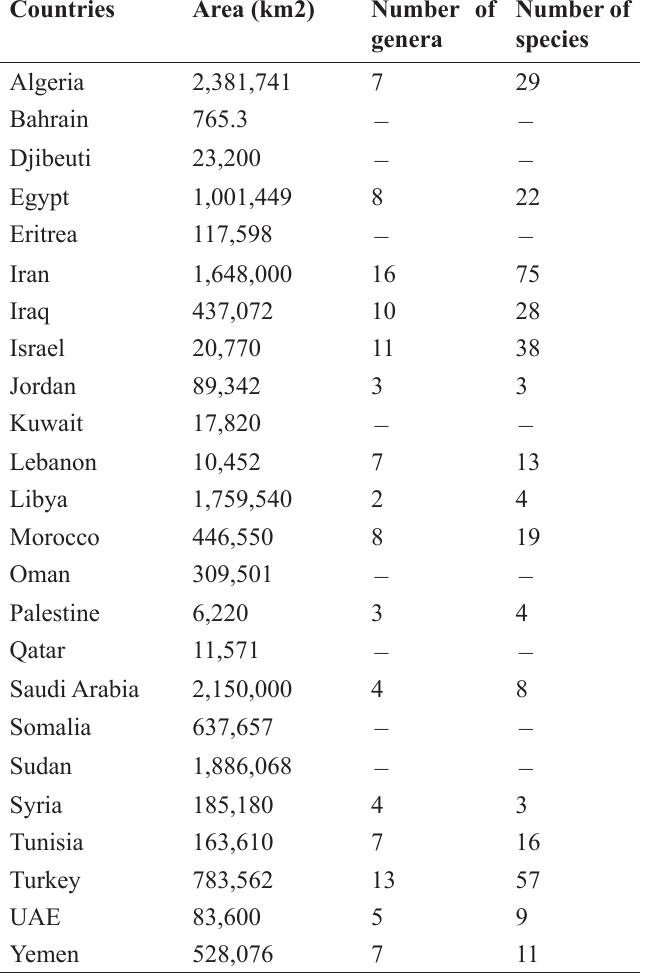
Table 1. Numbers of recorded genera and species of Aphidiinae in different countries of the Middle East and North